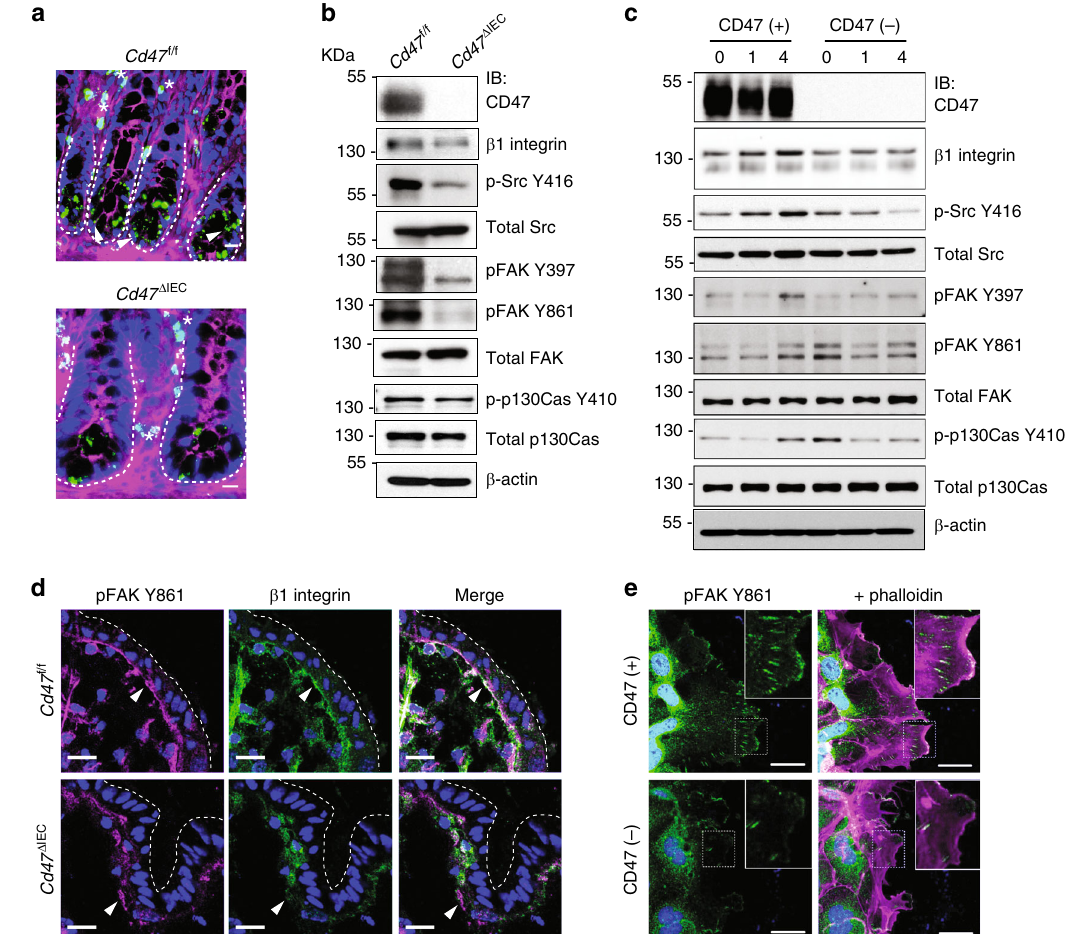
Fig. 6 CD47 associates with β 1 integrin and promotes focal adhesion formation. a In situ proximity ligation assay utilizing antibodies against CD47 and β 1 integrin indicating close association between CD47 and β 1 integrin in the colonic epithelium. Positive PLA signals are shown in green, beta-catenin